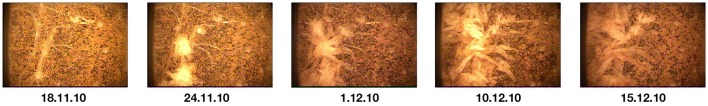
Detection of Phelipanche aegyptiaca tubercles with a minirhizotron camera.